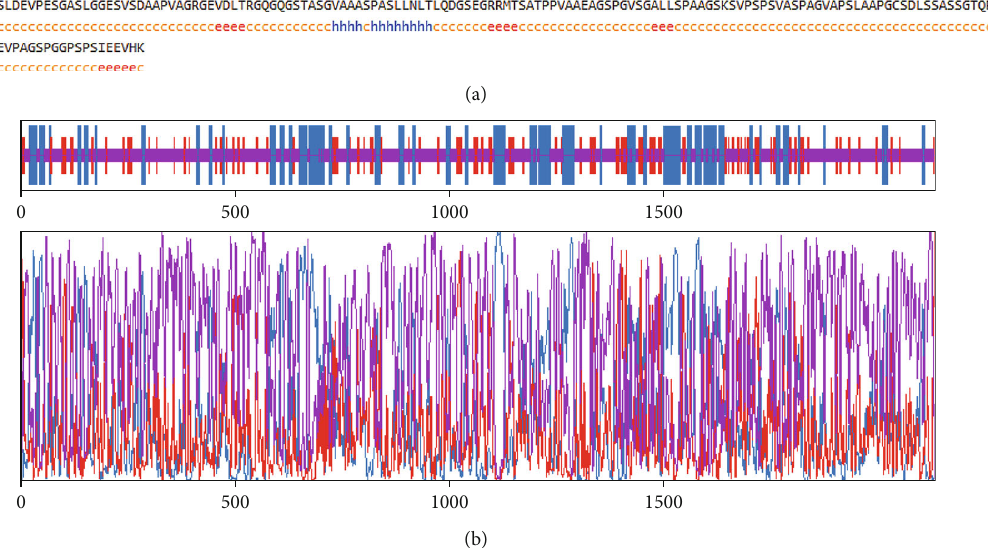
Figure 3: (a) GOR4 server results suggested that CDPK7 encompasses 502 alpha-helix, 320 extended strands, and 1311 random coils in secondary structure; (b) graphical result of the secondary structure prediction of CDPK7 using the GOR4 online